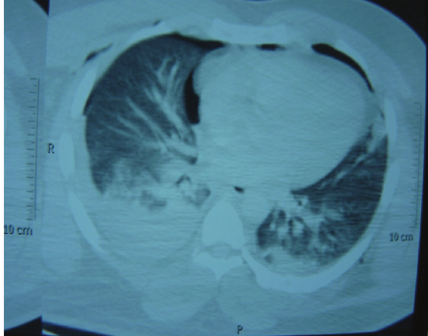
Figure 2: Thorax CT image of the patient.